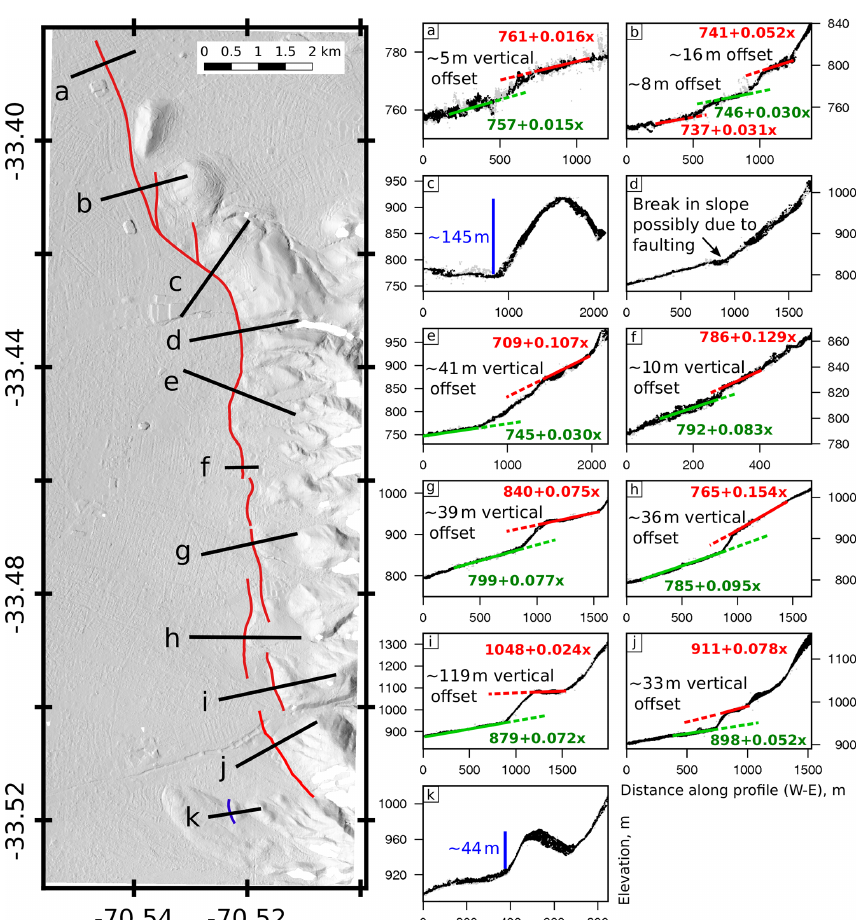
Figure 4. The northern section of the Pléiades-derived DEM (2m resolution) indicated in Fig. 3. The black points on the profiles are ground pixels within a 30m swath of the profile line from the Pléiades-imagery-derived point cloud, while the grey are from the SPOT point cloud. The red and green lines are best fit lines through the point clouds either side of the fault scarps. The scarp height is estimated from the vertical offset between these two lines. The blue lines are the height of anticlines measured from the downslope